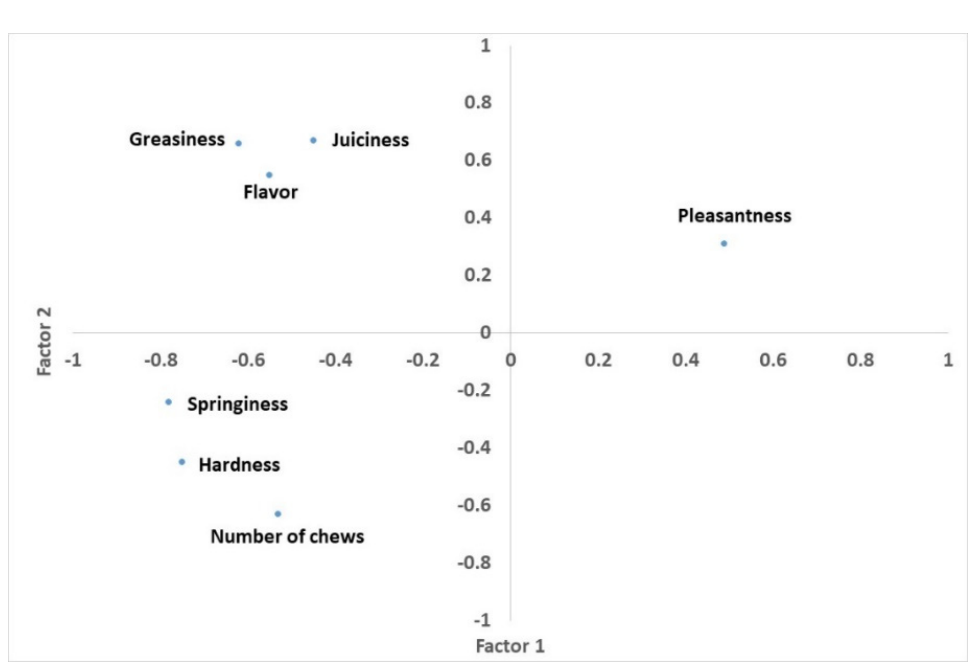
Figure 1. Projection of the sensory quality measurements in the plane defined by the first two principal components. The results of the PC analysis for carcass and sensory parameters in Rubia de El Molar suckling lambs’ meat are presented in Table 4. Including weight in the principal compo- nents analysis, three factors were detected. The first principal component was characterised by live weight. High coefficients were observed for hardness and pleasantness. This first principal component explained almost 40% of the total variation